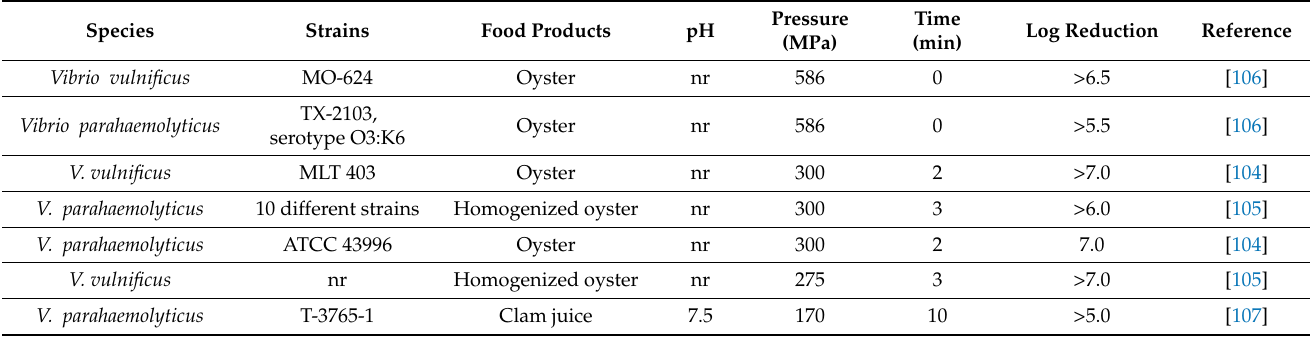
Table 5. Inactivation of Vibrio in oysters and clam juice by high-pressure processing (HPP) *.